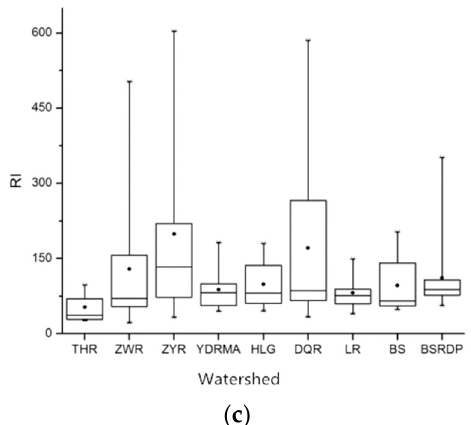
Figure 2. ( a ) Enrichment factors (EF) of heavy metals in the Haihe Basin; ( b ) Eutrophication index (EI) in the Haihe River Basin; ( c ) Potential ecological risk index (RI) of heavy metals in the Haihe Basin.